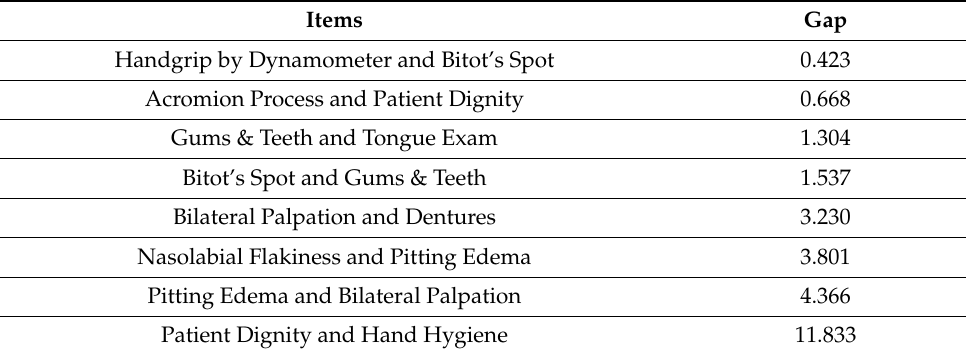
Table 4. Gaps Between Items.